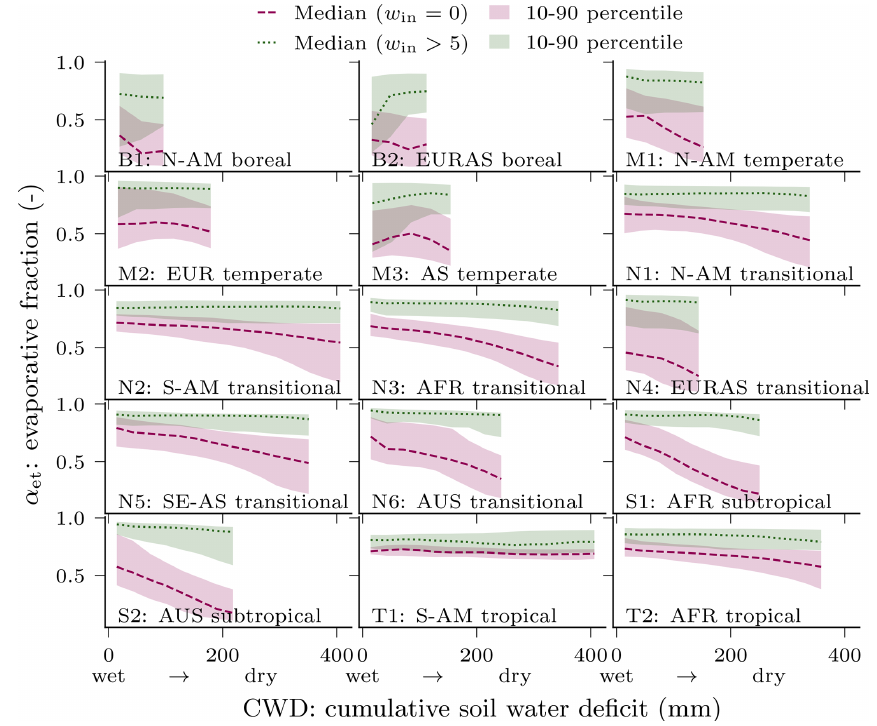
Figure 7. Relationship between evaporative fraction ( α et ) and cumulative soil water deficit (CWD) for different hydroclimatic regions. The lines shows the respective percentiles of the spatiotemporal conditional distribution P(α et | C ∈ B i ) , where C is the cumulative soil water deficit on the x axis discretized into N = 10 bins B = (cid:8) [ 0 , 40 ),..., [ 360 , 400 ) (cid:9) . The lines represent the median, and the 10 to 90th i = 1 ,...,N percentile is displayed as a shaded area. The red colors depict conditions without water input, P(α et | C ∈ B i ,w in = 0 ) , i.e., no precipitation or snowmelt, and green colors represent high water input larger than 5mm, P(α et | C ∈ B i ,w in > 5 ) . Note that the CWD minimum was subtracted per grid cell. To exclude cells with a low CWD variability, only the cells in the top 60% maximum CWD were used. The CWD dynamics correspond to negative soil moisture, i.e., a larger CWD implies drier soils. The plots are based on global daily cell time steps from 2009 to 2014.